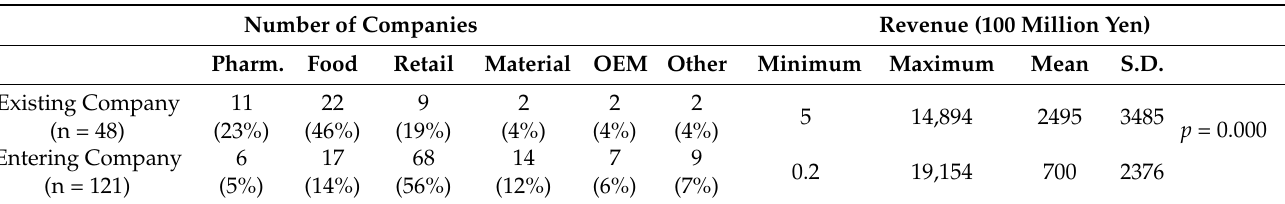
Table 1. Number of companies by attribute and corporate revenue.